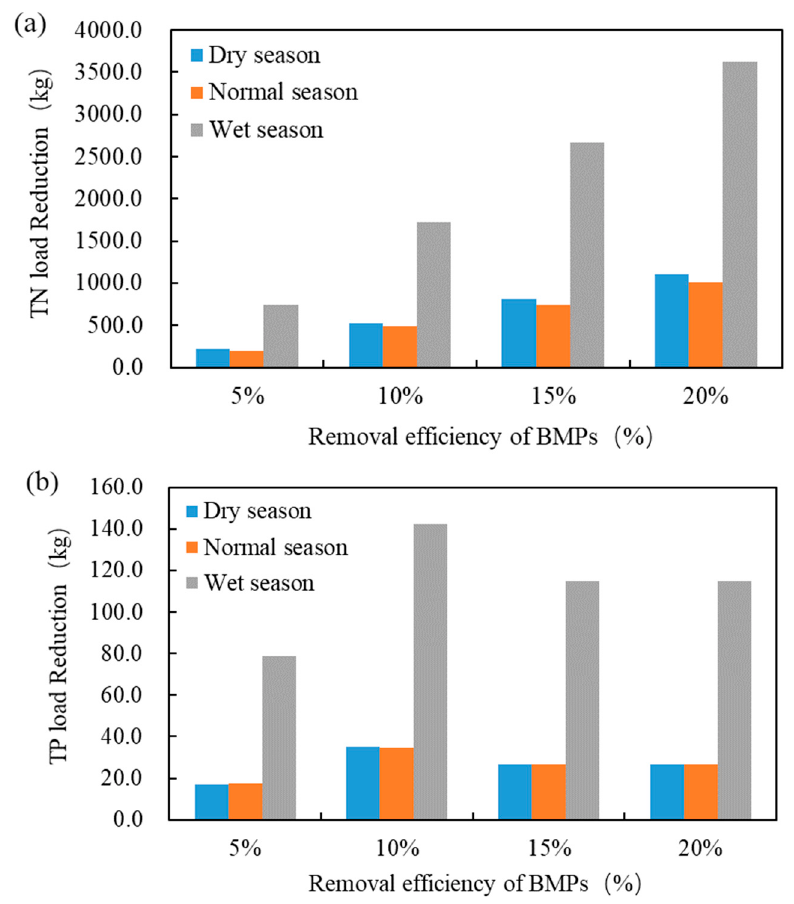
Figure 7. TN ( a ) and TP ( b ) reduction at different removal efficiency of best management practices (BMPs).